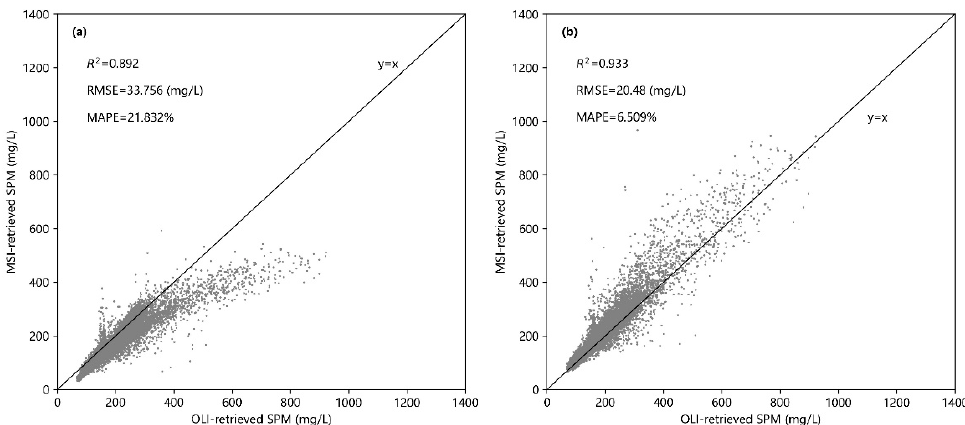
Figure 6. Correlation of SPM values retrieved from OLI and MSI images in Shengjin Lake using different models: ( a ) the optimal models with different forms, ( b ) the same form of models.